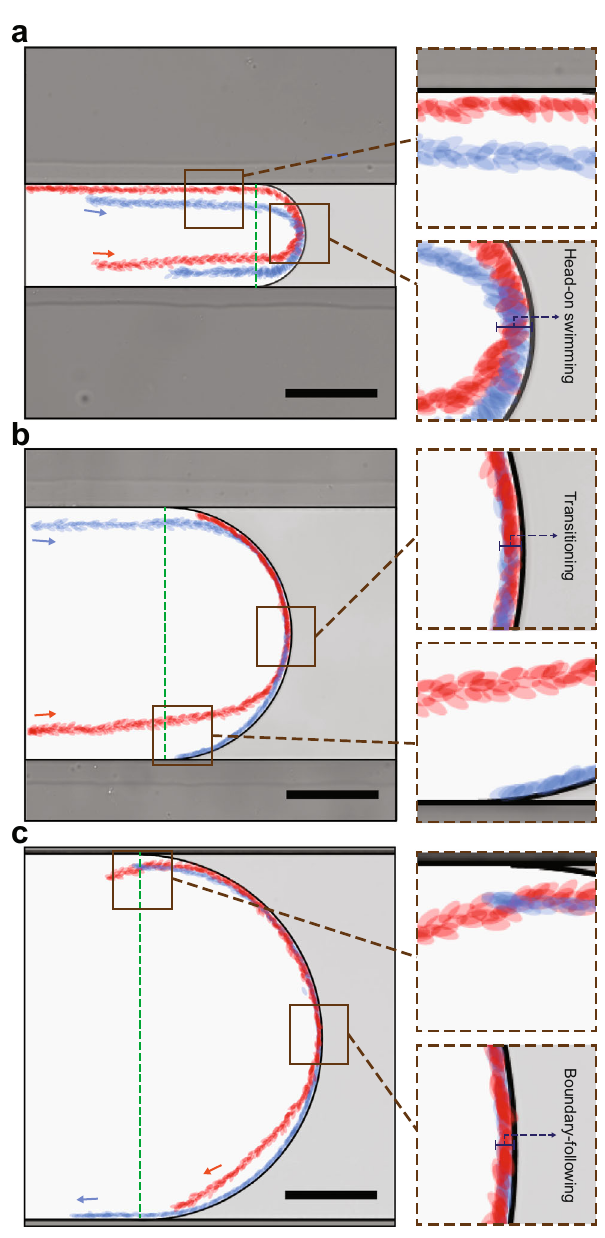
Fig. 6 Sperm motility behavior at curved interfaces in microchannels that represent the increasing complexity of the female fallopian tube geometry. Overlaid trajectories of two representative sperm (head shown in red and blue) in microchannels that mimics the relevant range of curvatures in infundibulum, ampulla, and isthmus, with sperm exhibiting ( a ) head-on swimming behavior in the attacking mode, ( b ) a combination of head-on swimming and boundary following behavior in the transition mode, and ( c ) boundary-following behaviors in the progressive mode, respectively. Each experiment was repeated four times independently with similar results for ( a – c ). Images were contrast-adjusted for clarity. Scale bars, 100 µ